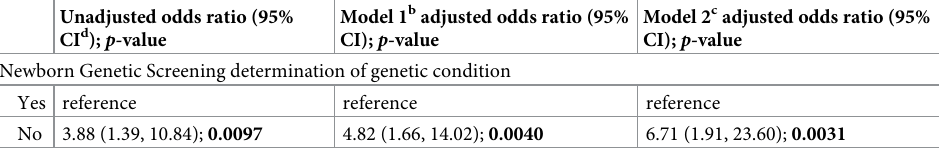
Model adjusted for sex, race/ethnicity, age, premature birth, and birth weight. D Confidence Interval. Boldface indicates statistical significance ( p <